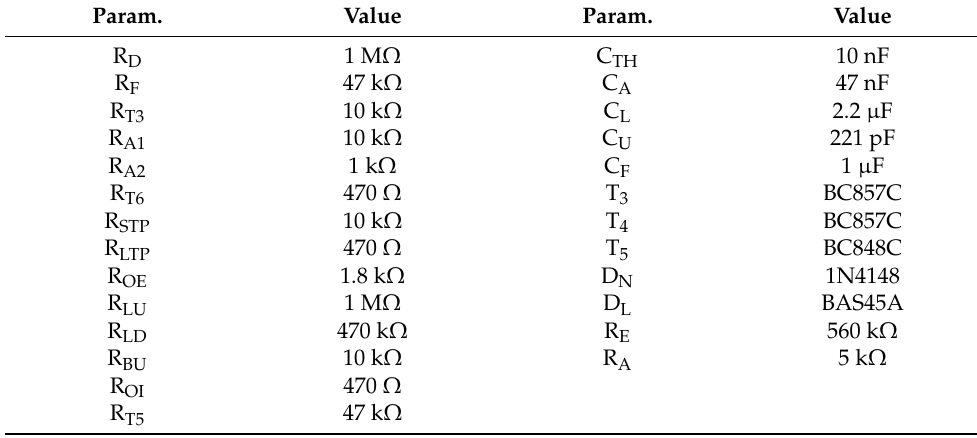
Table A2. Parameters for the SYN.